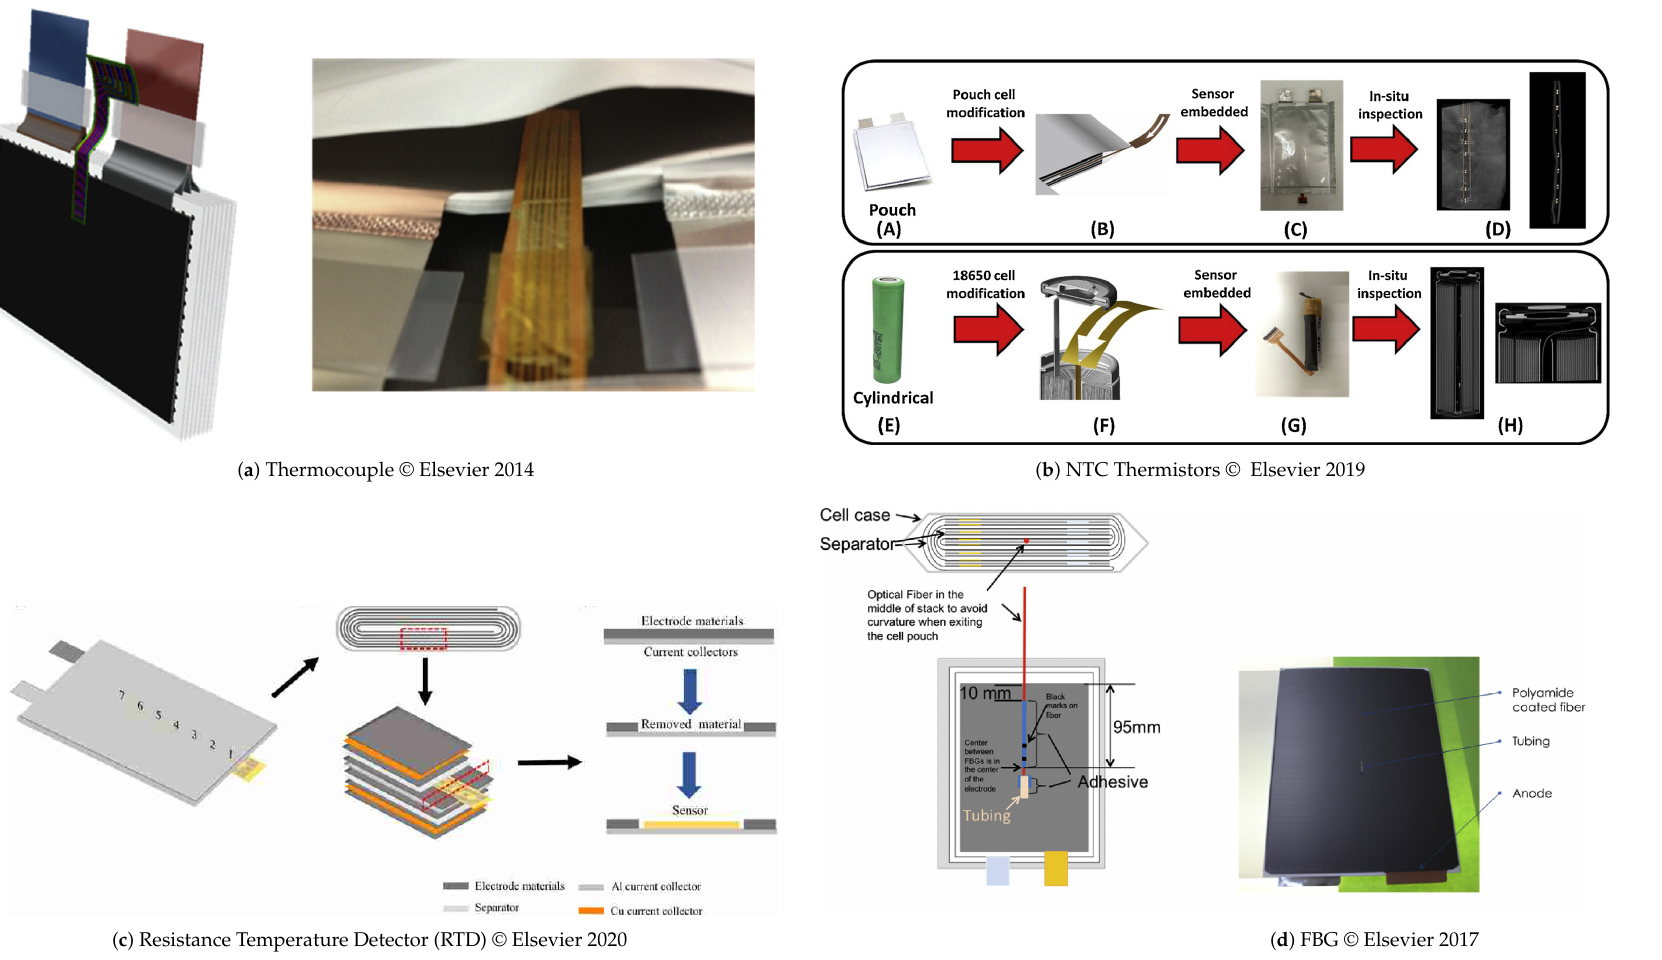
Figure 5. Integration of various sensors: ( a ) Thermocouple attached to the outer face of the cell stack of a 3Ah pouch cell [334]. ( b ) NTC thermistors integrated within the cell stack of a 5.5Ah pouch cell ( A – D ) and in the mandrel core of an 18650 cylindrical cell ( E – H ) [331]. ( c ) RTDs integrated within electrode cavities [333]. ( d ) Integration of an Fiber Bragg Grating Sensor (FBG) within the cell stack of a 15Ah pouch cell [336]. All reprinted with the permission of Elsevier,